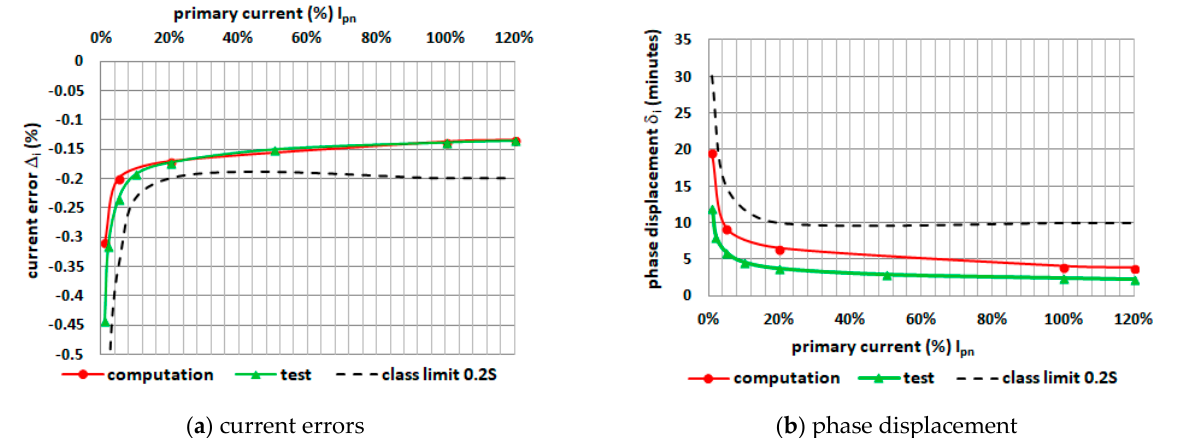
Figure 7. Comparison of the characteristics of the current error ( a ) and phase displacement ( b ) from the calculations and tests for 600 A/5 A current transformers with a toroidal core at a power load of S n = 5 VA. cos φ = 0.8 (I pn = 600 A).